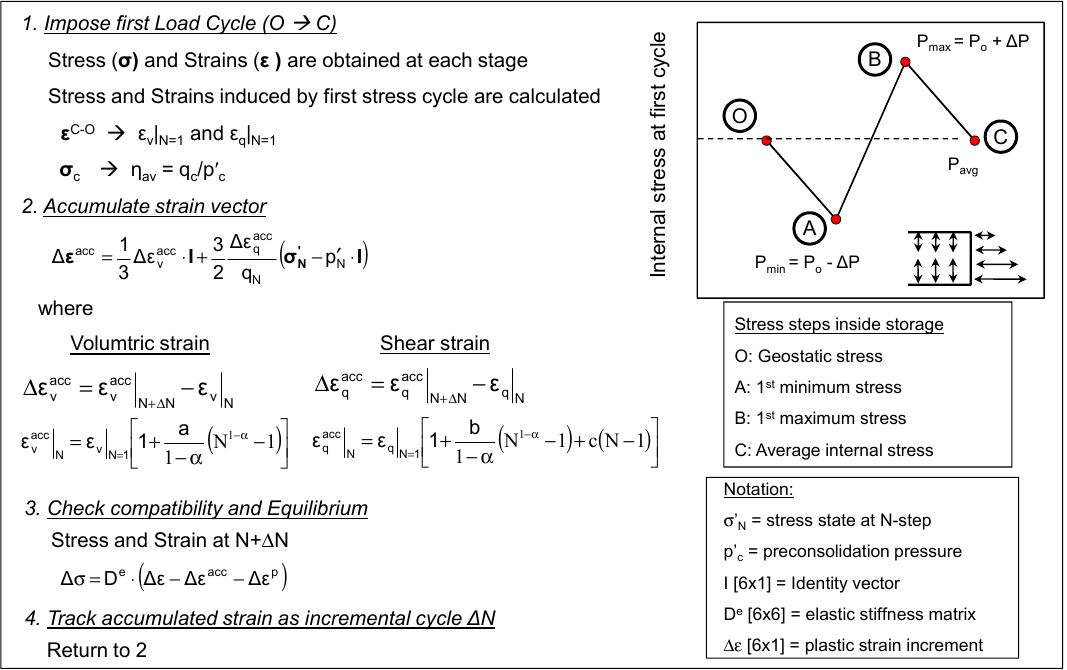
Figure 3. Numerical algorithm to simulate the underground energy storage subjected to repetitive internal stress.